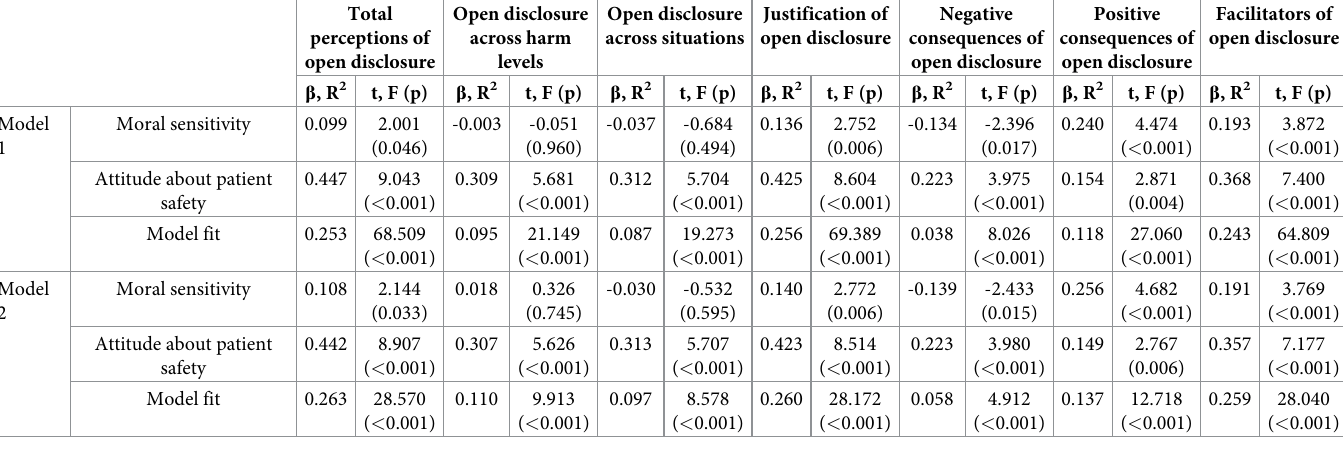
Table 5. Effects of moral sensitivity and attitude about patient safety on perceptions of disclosure of patient safety